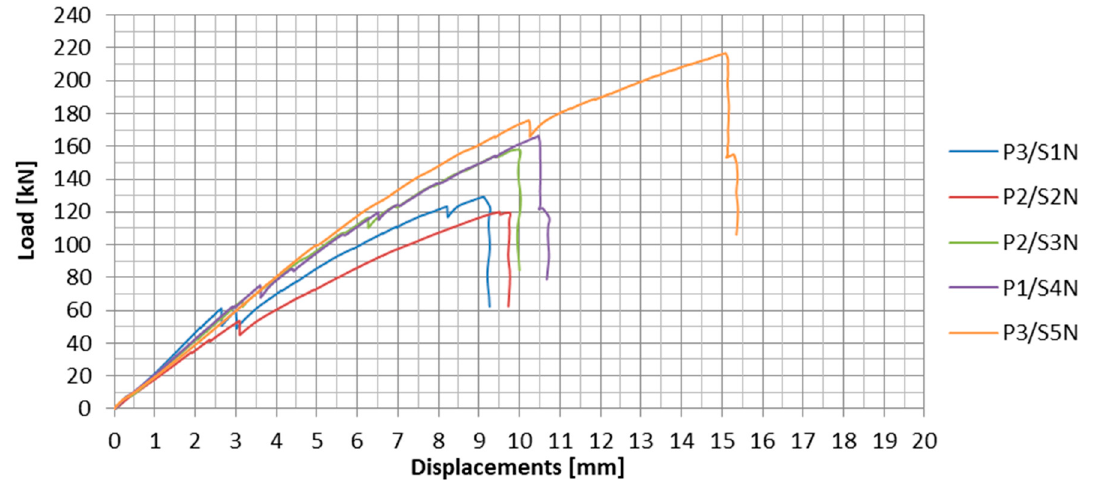
Figure 23. Load-displacement plots for the specimens with the maximum failure load in the subsequent